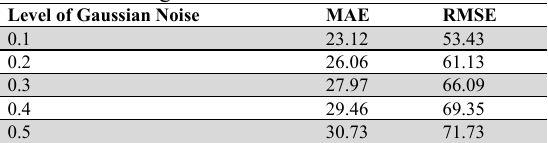
Level of noise in gaussian Processes Level of Gaussian Noise